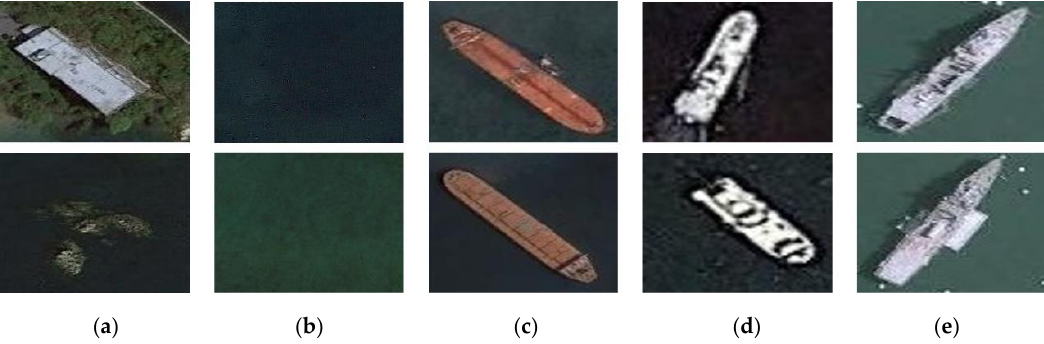
Figure 7. Samples of our dataset: ( a ) land, ( b ) marine, ( c ) cargo ship, ( d ) steamer, ( e ) warship.